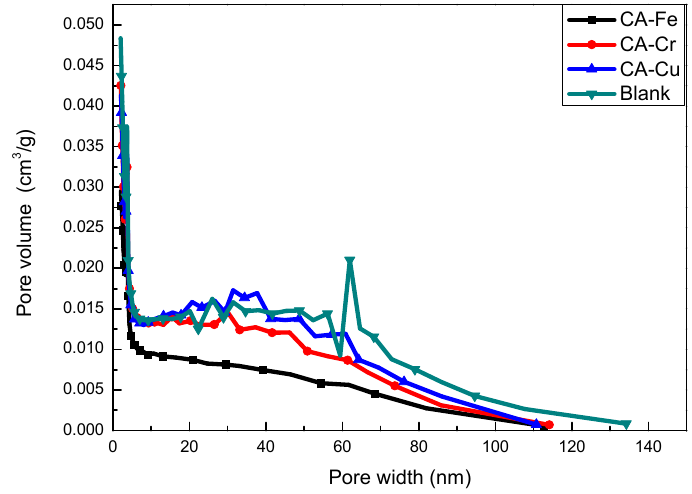
Figure 5. Pore size distribution in the CA-X samples and the Figure 5 . Pore size distribution in the CA-X samples and the blank. Figure 5 . Pore size distribution in the CA-X samples and the blank.